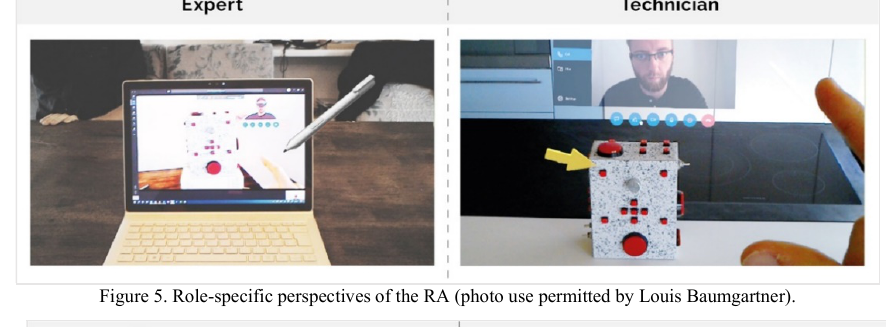
Figure 5. Role-specific perspectives of the RA (photo use permitted by Louis Baumgartner).